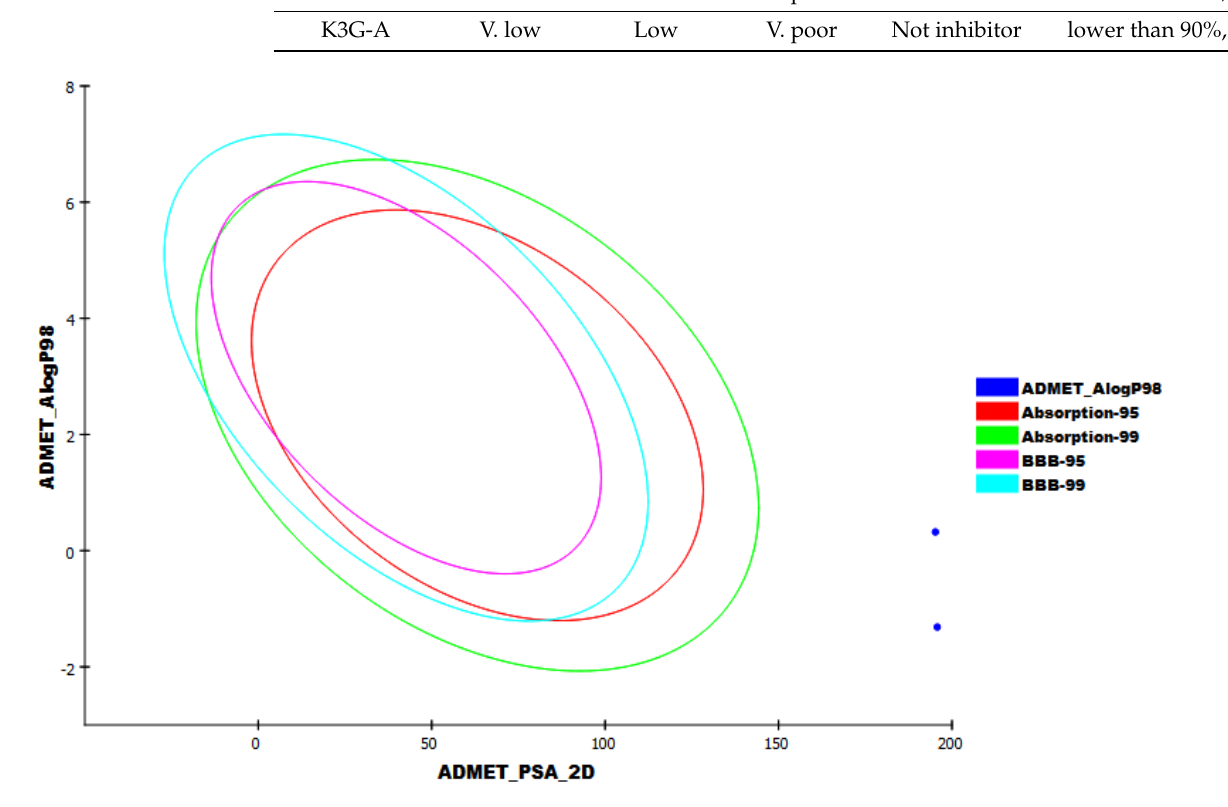
Table 5. Toxicity properties for K3G-A and